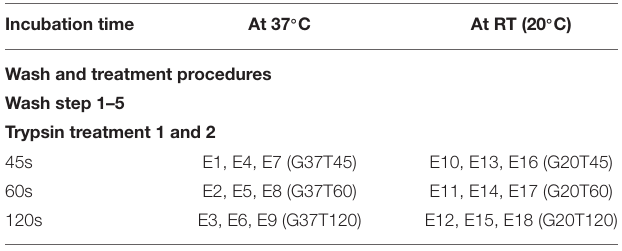
TABLE 1 | Experimental set-up of the treatment procedure for the second in vitro experiment; E: Sample consisting of 5 embryos, Between brackets: the group